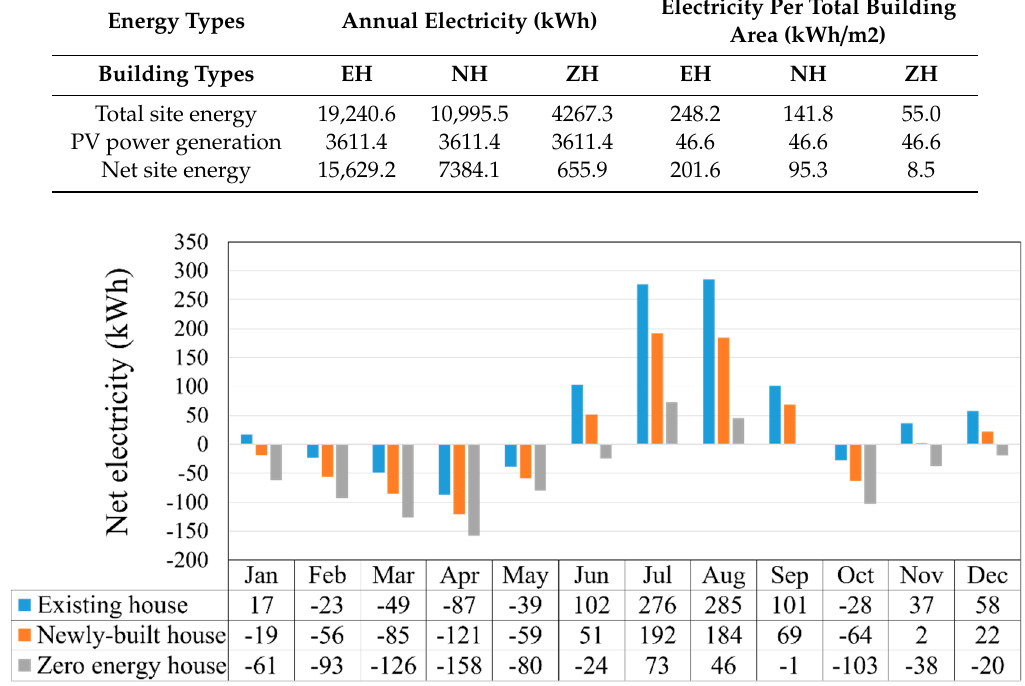
Figure 3. Monthly net electricity by building types.